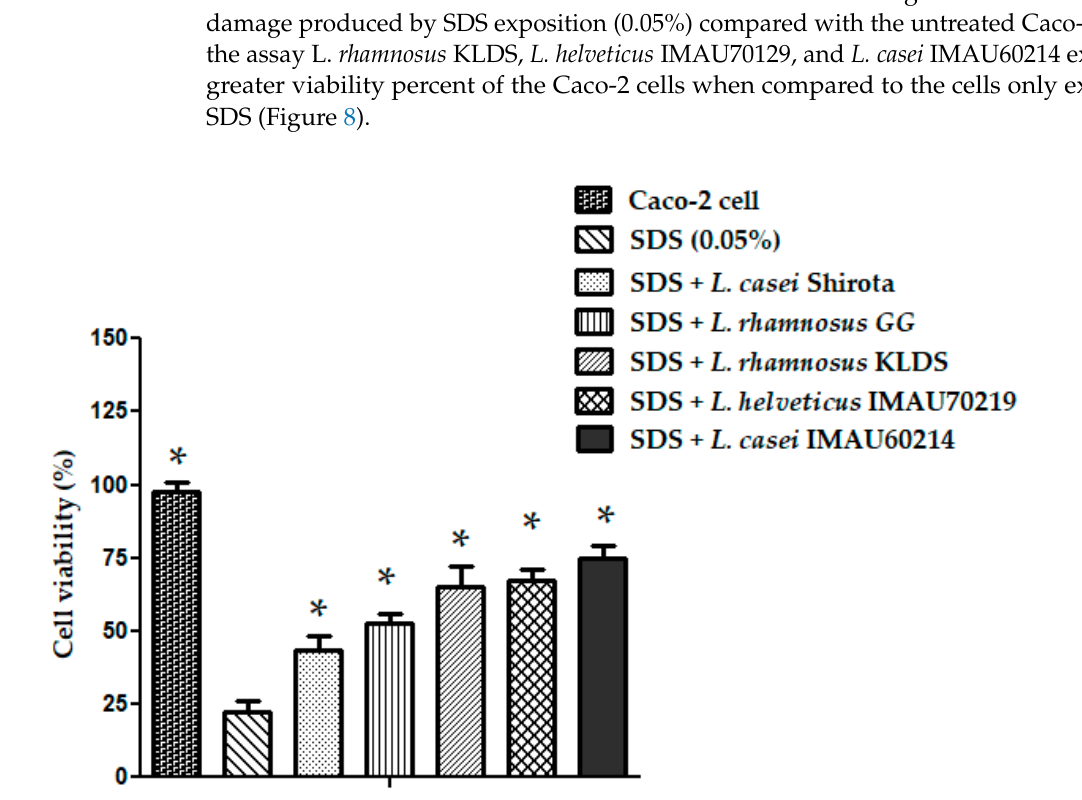
Figure 8. Protective effect on Caco-2 cells induced by Lactobacillus strains. The residual cell viability was measured by the mean MTT assay. The results are expressed in percentages. Values represent the mean ± SD of three separated assays. * significant differences among Lactobacillus strains versus SDS 0.05% ( p < 0.05).